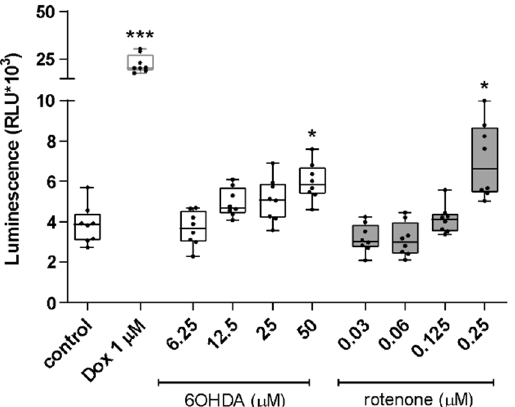
Figure 2. Highest non-lethal concentrations of 6-OHDA (50 µM) and rotenone (0.25 µM) induced an evident increase in caspase 3/7 activity. In order to assess whether non-toxic concentrations of 6-OHDA and rotenone could induce the activation of caspase 3/7, we used the Caspase-Glo 3/7 Assay. Doxorubicin (Dox, 1 µM) was used as a positive control. Data are represented in boxplots in which each dot represents the mean of an independent cell population ( n = 8), measured in duplicate. Kruskal–Wallis test (One-way ANOVA on ranks) pairwise (control vs. 6-OHDA or control vs. rotenone) was used to assess statistical significance, (*) p < 0.05, (***) p < 0.001.